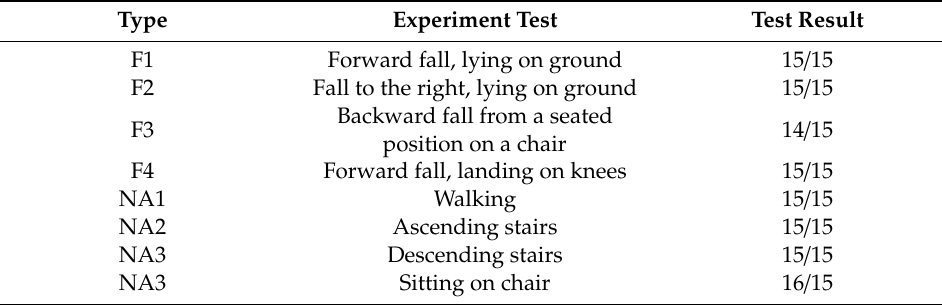
Table 3. Test results for the evaluated types of fall and normal activities.